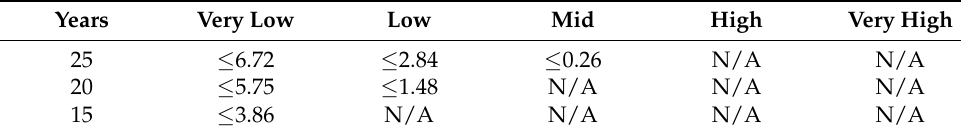
Table 15. Fixed Discount Rate Pure Case.